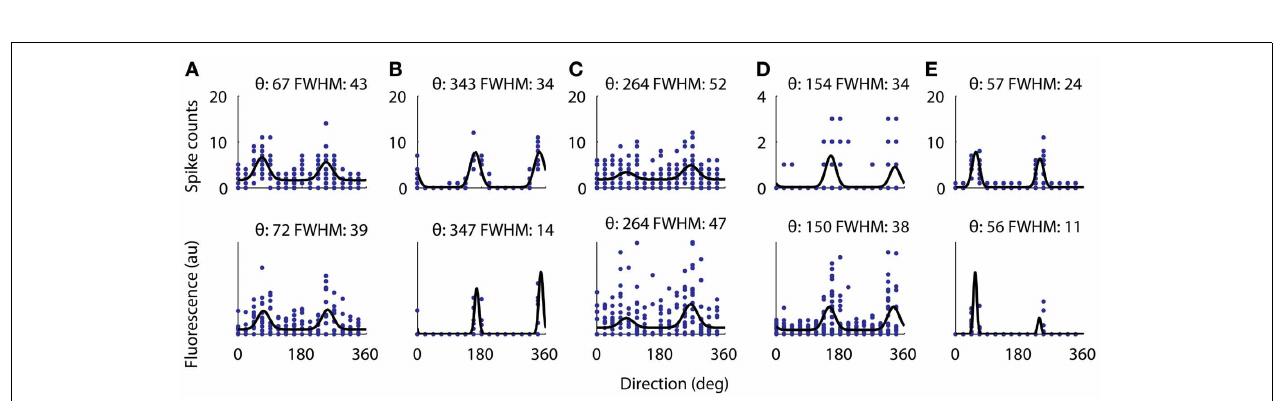
of the activity (denoised) or not (raw). The PC removed data was significant better at all time bins ( p < 0 . 05, ranksum test) (D) The average correlation coefficient between the spike count and the inferred firing from 12 cells recorded with both the AOD and galvanometric system. The error bar shows standard error of the mean, and the AODs recovered spiking significantly better than the galvos at 100ms ( p < 0 . 05, paired t -test). (E) The sizes of the populations recorded with both the galvanometric and 3D-RAMP system for data shown in panel d.